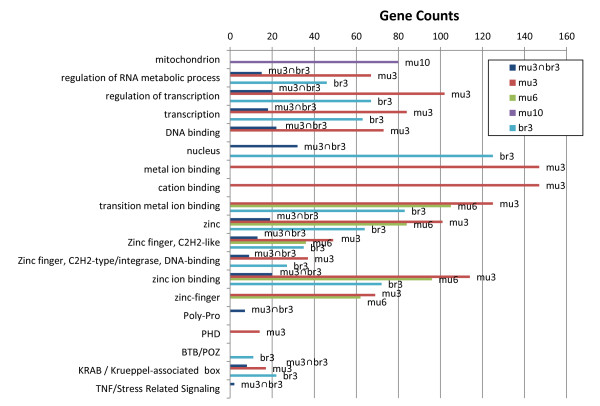
Functional groups significantly enriched among genes downregulated in Spalax under hypoxia. Bars represent gene counts for the different gene ontology terms.